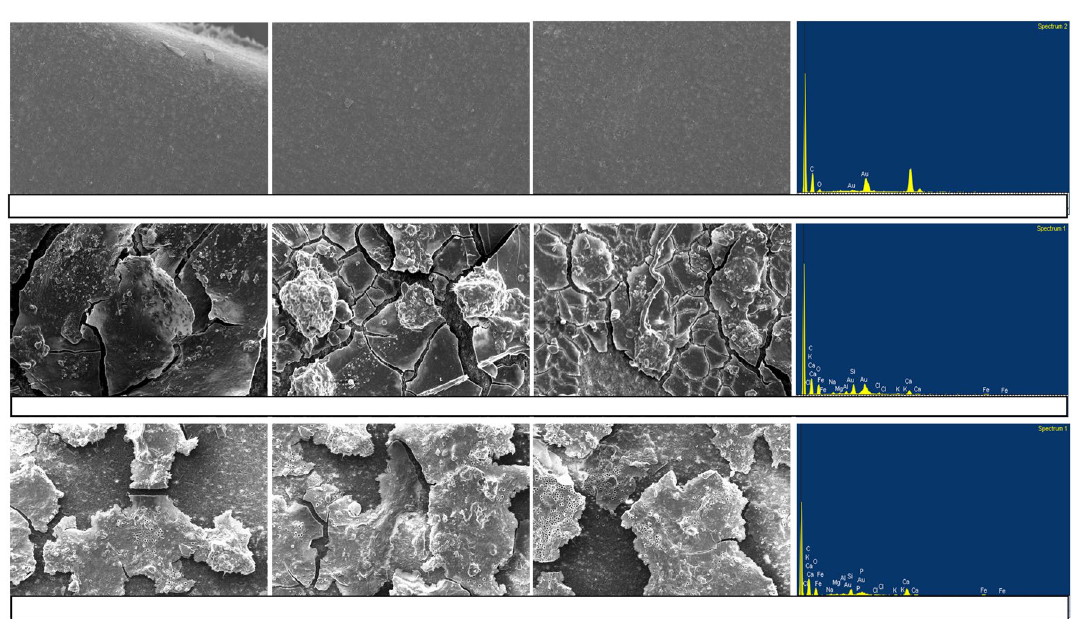
Figure 10. SEM–EDX for a pristine MTI lateral (top row), SEM–EDX for deposited sediment (DS) from AF effluent (second row), and SEM–EDX for (DS) from HFCW effluent (bottom